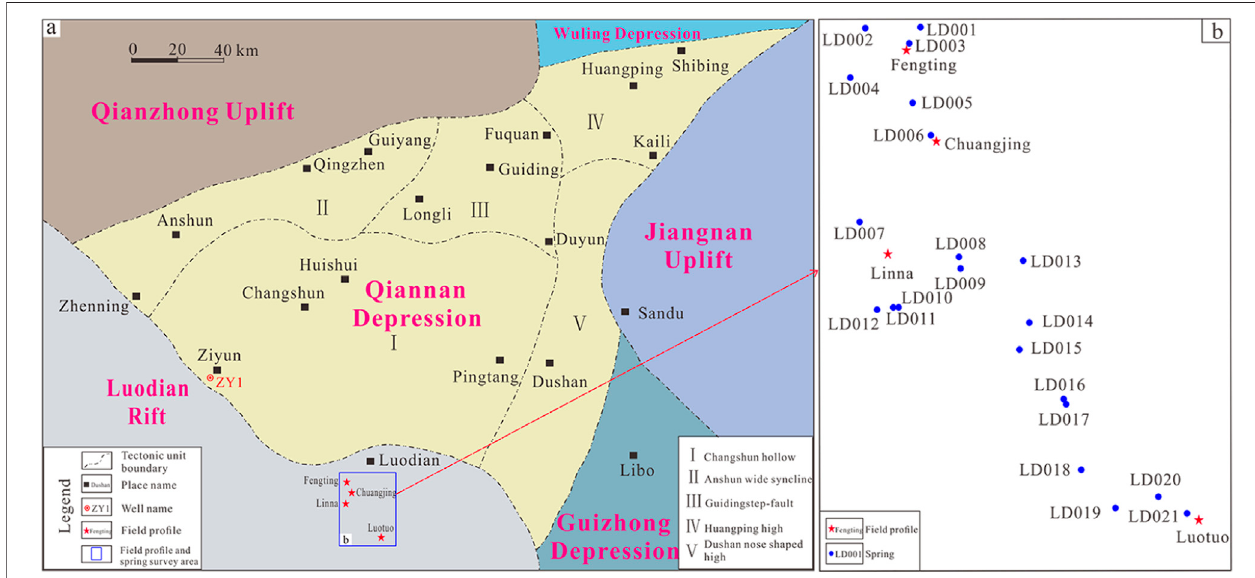
FIGURE 1 | Structural outline map, fi eld pro fi le, and spring survey map of the Qiannan area.